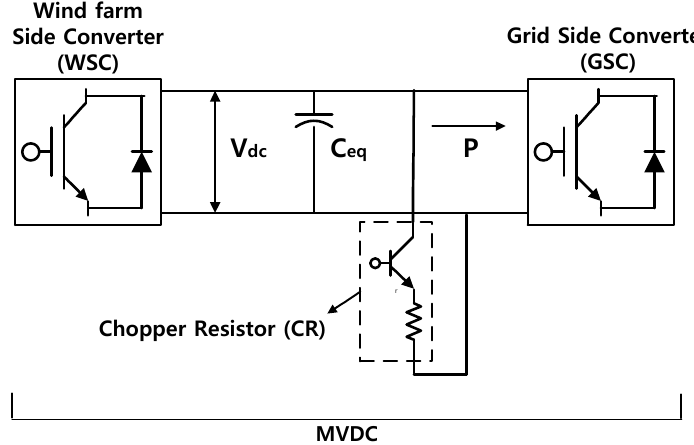
Figure 2. The concept of the CR linked to the DC